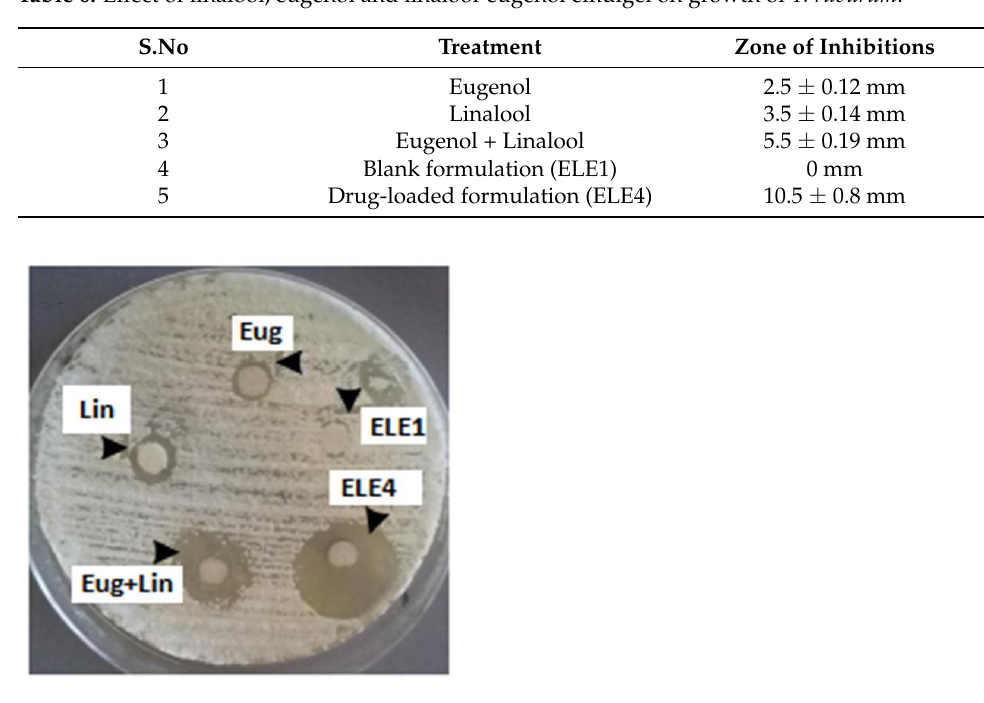
Figure 7. Zone of inhibitions of eugenol, linalool, eugenol + linalool, ELE1 and ELE2.